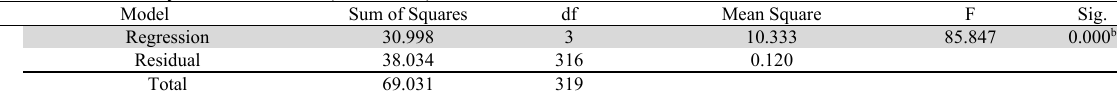
The Results of Analysis of Variance (ANOVA a )